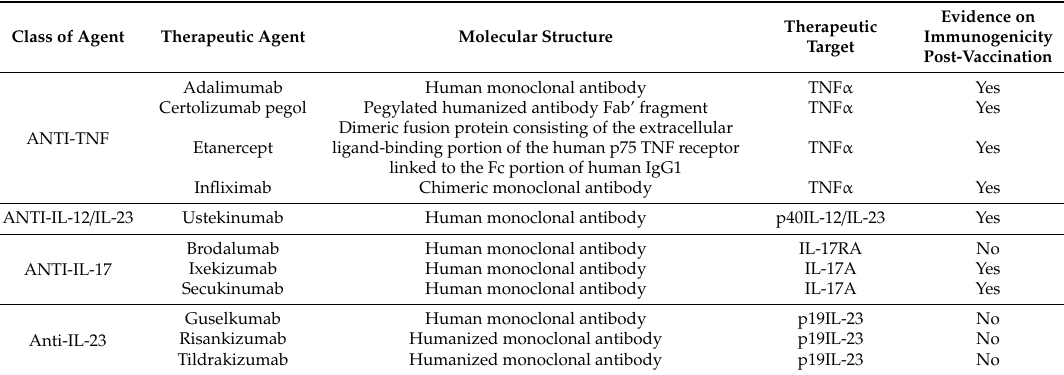
Table 2. Details about biologics and